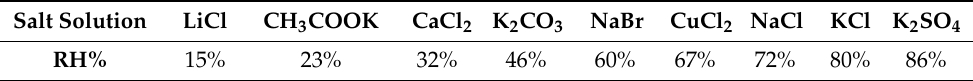
Figure 2. Experimental setup used for electrical measurement of the device under test (DUT). Table 1. Relative humidity (RH)% achieved in the airtight jar by the supersaturated solution of different